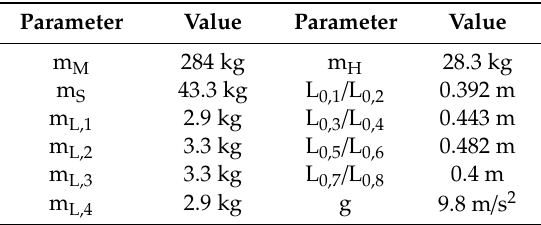
Table A3. Physical parameters of